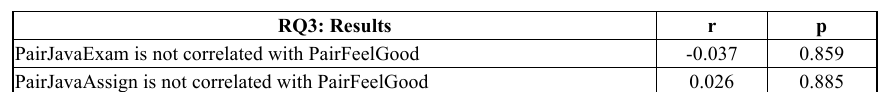
Table 7. Results summary of